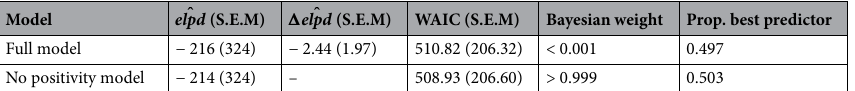
Table 2. Experiment 2 model fit statistics. Estimated expected log-posterior density (elpd), Watanabe–Akaike Information Criterion (WAIC), Bayesian stacking weights, and the proportion of participants whose data was best predicted by each model. Larger positive values of elpd and smaller values of WAIC indicate better predictive performance. The difference from the best-fitting model is represented as (cid:31) weights correspond to the weights assigned to the predictions of each model that maximise the log predictive density of future data